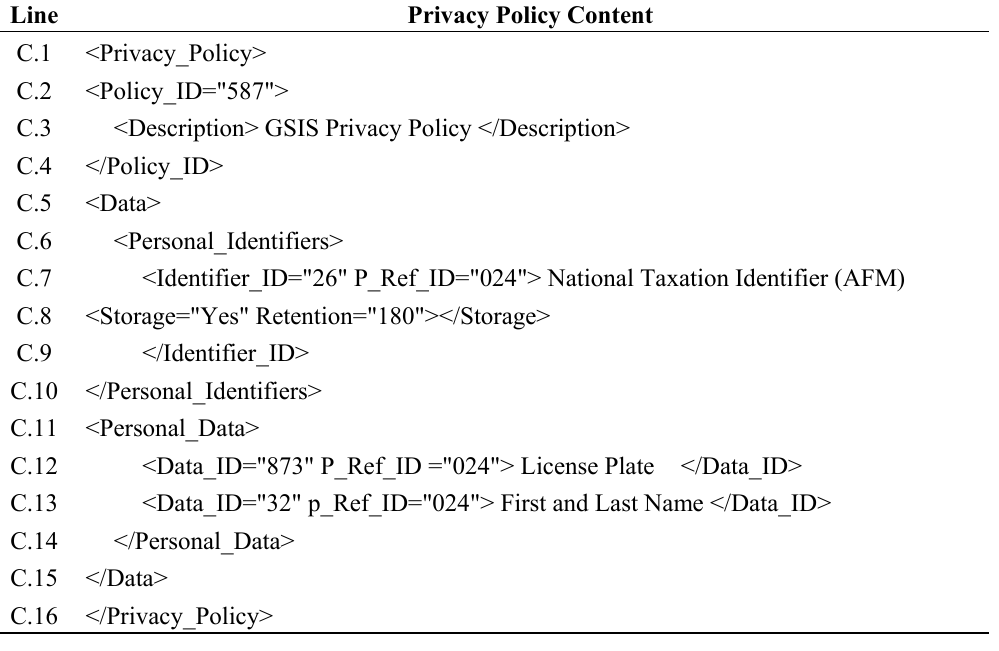
Table 3. GSIS Privacy